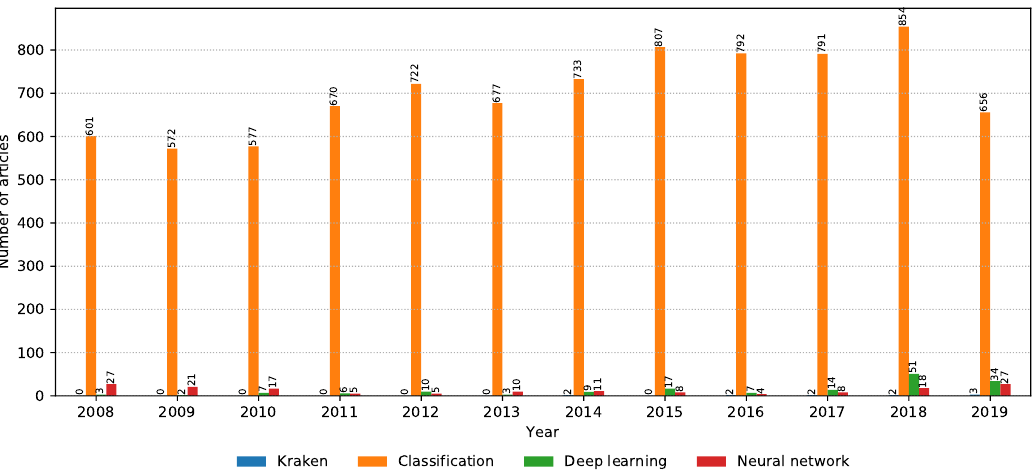
Figure 11. Number of relevant articles containing each property grouped into the machine learning